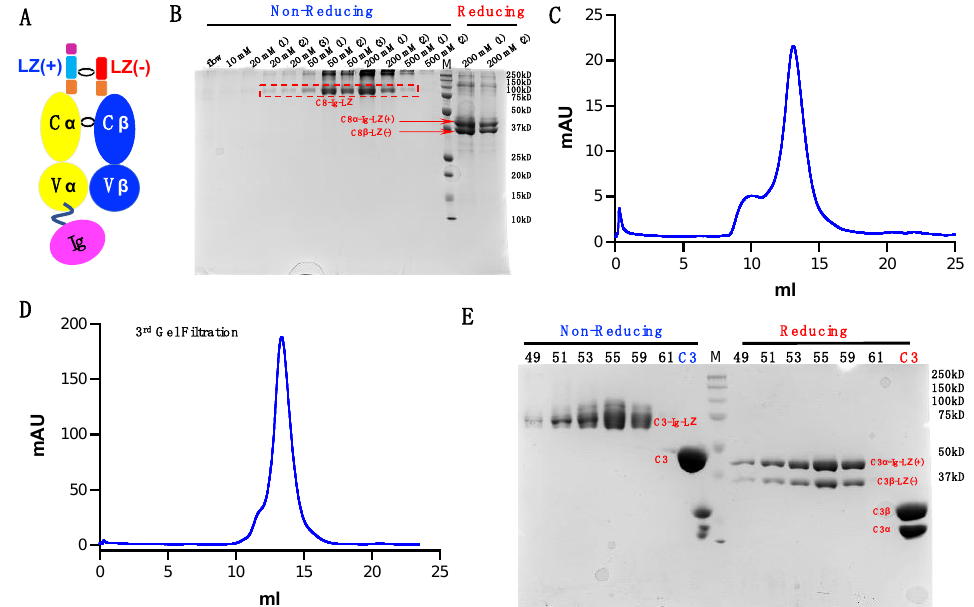
Figure 6. Additional TCRs produced using our dimerization strategy. ( A ) Modified TCR and TCR-Ig constructs. ( B ) C8-Ig from Ni-NTA column elution at stepwise imidazole concentrations. ( C ) C8-Ig elution from s200 Superdex. ( D ) Final round of s200 SEC for C3-Ig. ( E ) SDS-gel examining C3-Ig purity following the final round of s200 Superdex SEC.